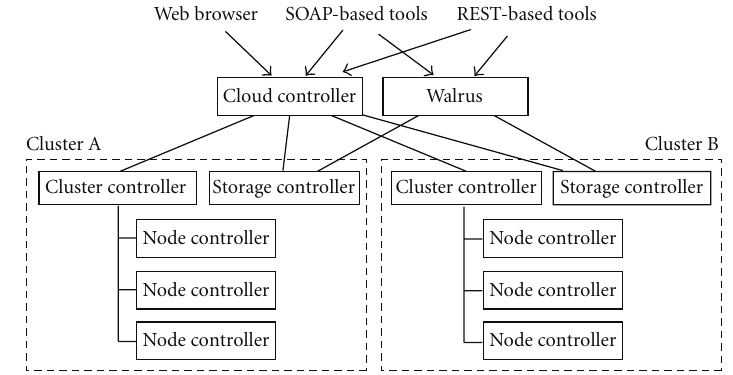
Figure 4: Eucalyptus architecture.